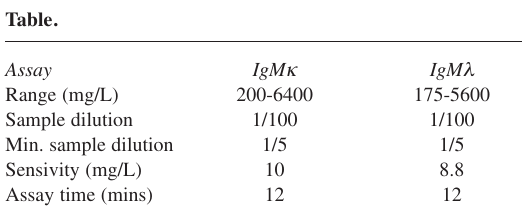
samples the IgM isotype was identified correctly and matched the IFE results. One MGUS patient had high polyclonal levels of IgM and a normal IgM k /IgM λ was reported. Summary/Conclusion. Normal ranges for IgM k and IgM λ in patient serum were established and we demonstrated that IgM k /IgM λ ratios can be a relevant indicator of IgM monoclonal protein